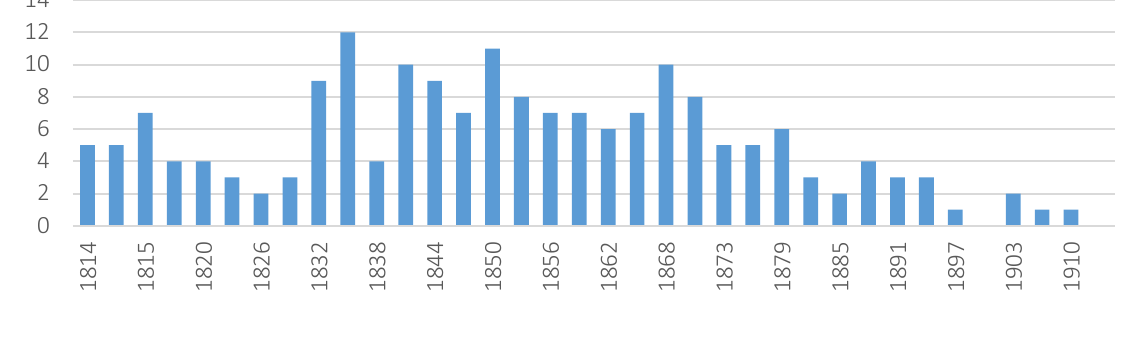
Figure 2. The number of Storting Haugeans during the parliamentarian terms 1814–1910